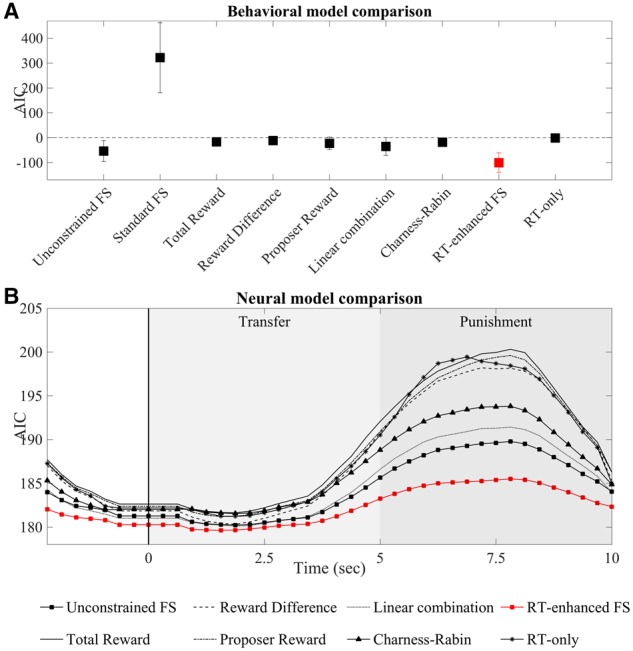
Behavioral and neural model comparisons. (A) Model AICs for punishment behavior. Smaller (more negative) values correspond to a relatively better fit of the corresponding model. The unconstrained Fehr–Schmidt model (Unconstrained FS) fitted punishment behavior consistently better compared to its constrained version (Standard FS), the simpler models (Total Reward, Reward Difference, Proposer Reward, Linear Combination), the Charness–Rabin model, and the RT-only model. Error bars represent standard deviation. (B) Model AICs for dlPFC activity. As with the behavioral data, the RT-enhanced FS model provided the best fit compared to all other models around the canonical hemodynamic response peak (i.e. around 7 s after transfer onset/2 s after punishment onset). The vertical black line indicates the time point when the transfer from the proposer to the responder was revealed, the light gray area indicates the transfer phase, and the darker gray area indicates the punishment window.